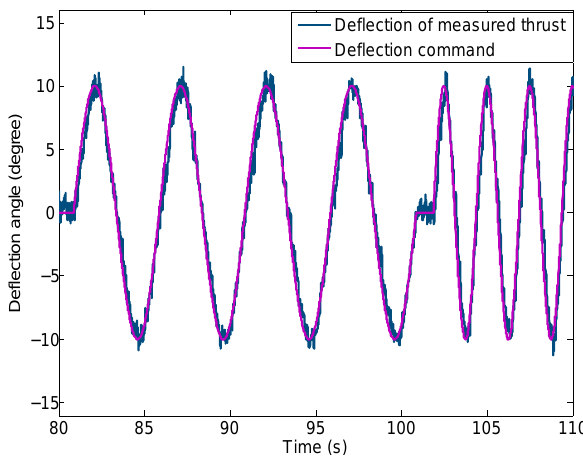
Figure 9. Comparison of the deflection angle command and the actual deflection angle of